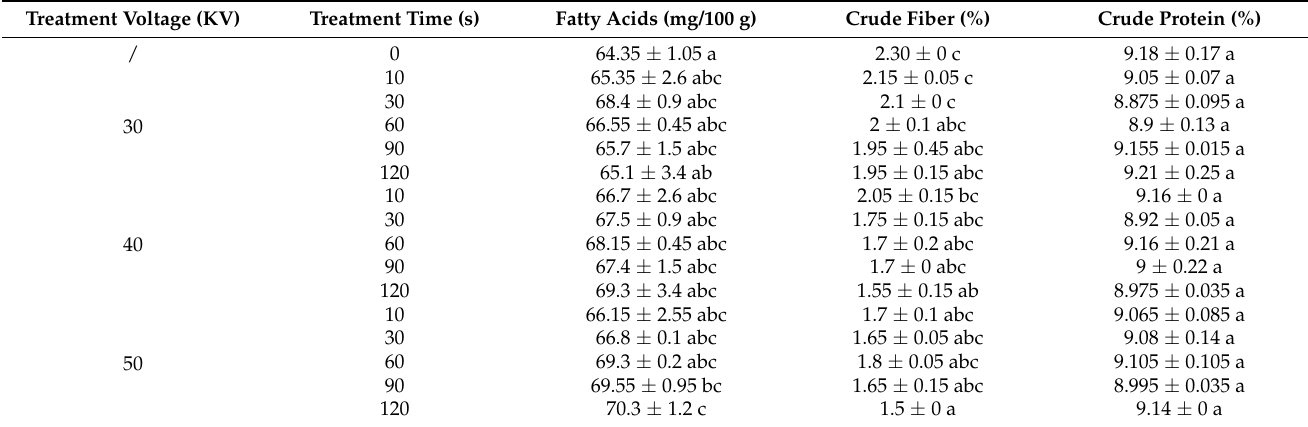
Table 3. Effects of cold plasma treatment on the nutrients of maize. Treatment Voltage (KV) Treatment Time